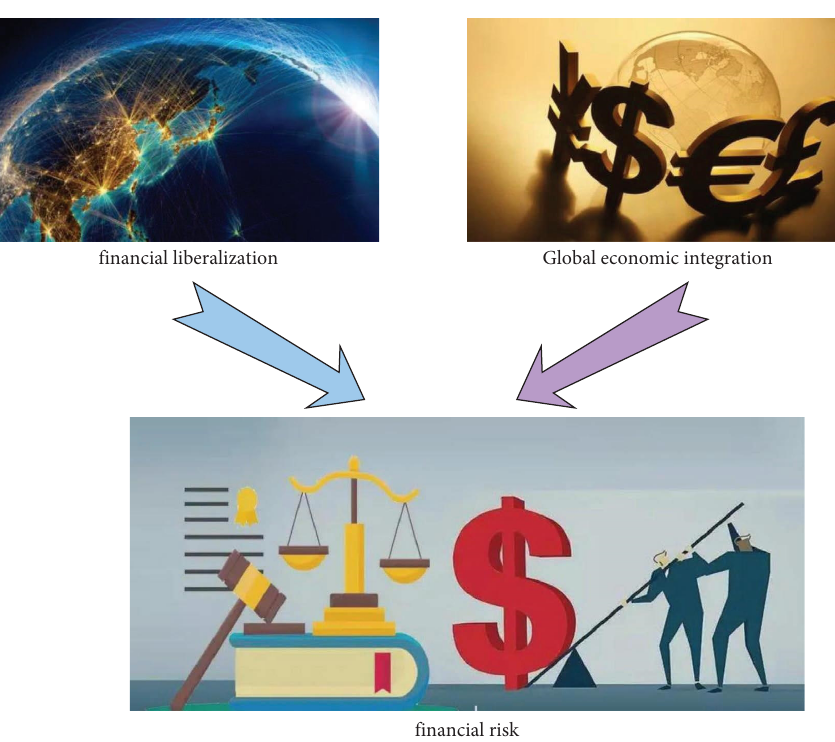
Figure 2: Financial